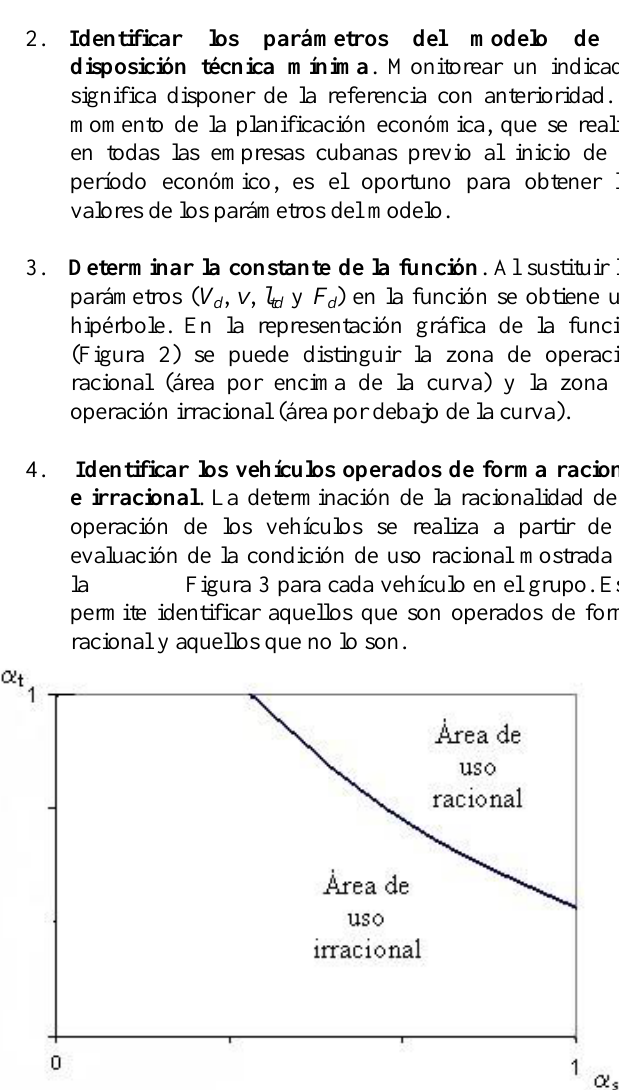
Figura 2: Comportamiento del CDT Mínimo en función del Coeficiente de Salida.